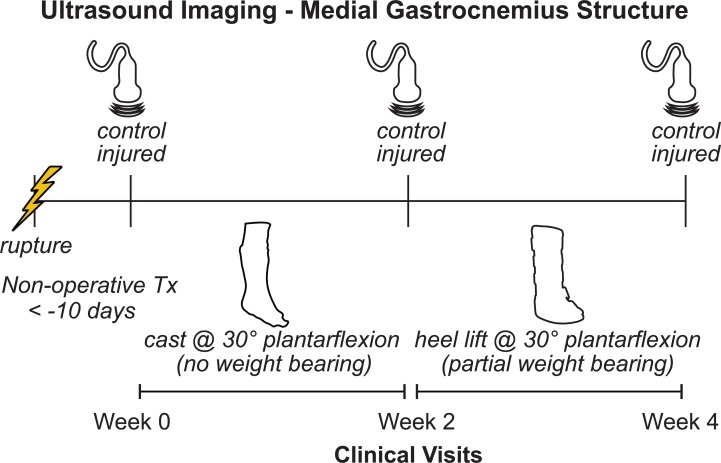
Study outline.Patients who suffered acute Achilles tendon ruptures and received non-operative treatment were enrolled in this prospective study at their initial clinical visit (week 0). We measured the structure of the medial gastrocnemius muscle on both the injured and contralateral sides using ultrasound at each clinical visit (weeks 0, 2, and 4). At initial presentation, patients were placed in a plantarflexed cast and were instructed to avoid any weight bearing. At the 2-week follow-up visit, the cast was removed and patients were placed in an orthopedic boot with heel wedges to place the foot in approximately 30 degrees of plantarflexion. Patients were instructed to apply light pressure to the foot while ambulating with crutches.